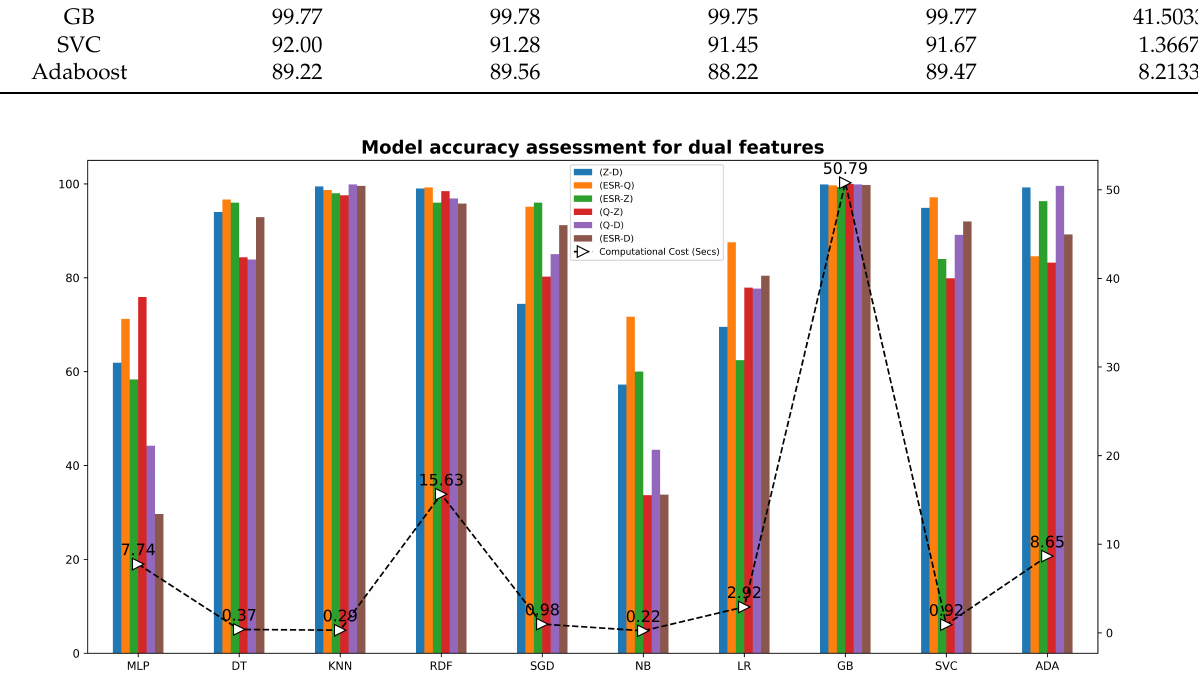
Figure 13. Model accuracy assessment for dual features. Going by the individual model for the dual features performance comparison, the multi-perception (MLP)—a fully connected class of feed-forward artificial neural network has average accuracy and computational cost (56.8683% and 7.74368 s), respectively. The combination of ESR and Q stands out for the MLP in terms of accuracy and computational costs. With (RSQ) dual features with the highest accuracy. The decision tree (DT)—easy and intuitive with its tree-based classification rules has average accuracy and computational cost (91.2933% and 0.374067 s), respectively, with the (RSZ) dual feature with a better prediction. The k nearest neighbours (KNN)—a supervised learning algorithm that looks